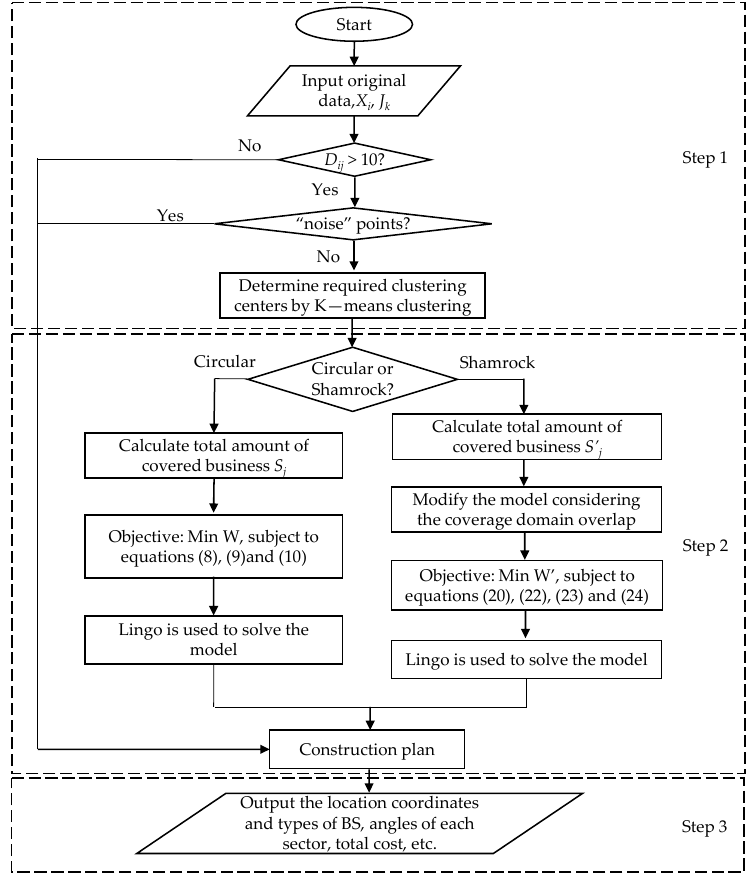
Figure 10. Flow chart of proposed algorithm.